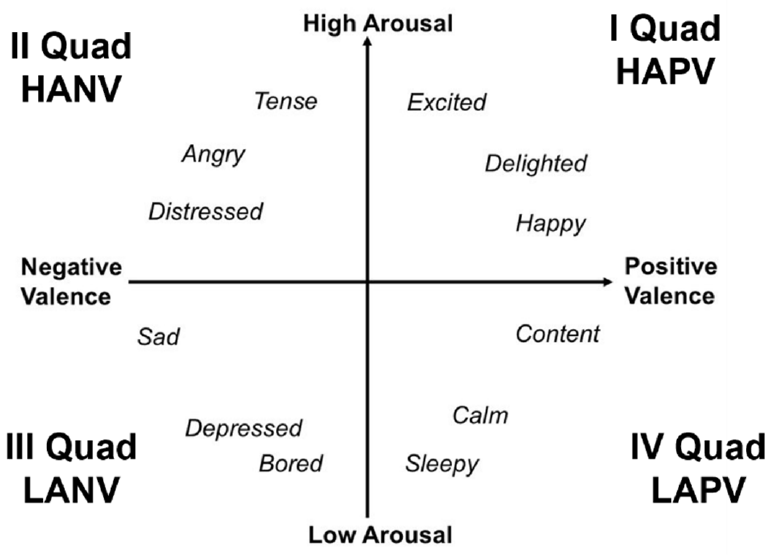
Figure 1. Graphical representation of the circumplex model of affect (CMA) with the horizontal axis representing the valence dimension and the vertical axis representing the arousal dimension (adapted from [30]). The first CMA’ quadrant (I Quad) is representative of High Arousal and Positive Valence (HAPV), the second quadrant (II Quad) correspond to High Arousal and Negative Valence (HANV), the third quadrant (III Quad) to Low Arousal and Negative Valence (LANV), and the fourth quadrant (IV Quad) to Low Arousal and Positive valence (LANV).